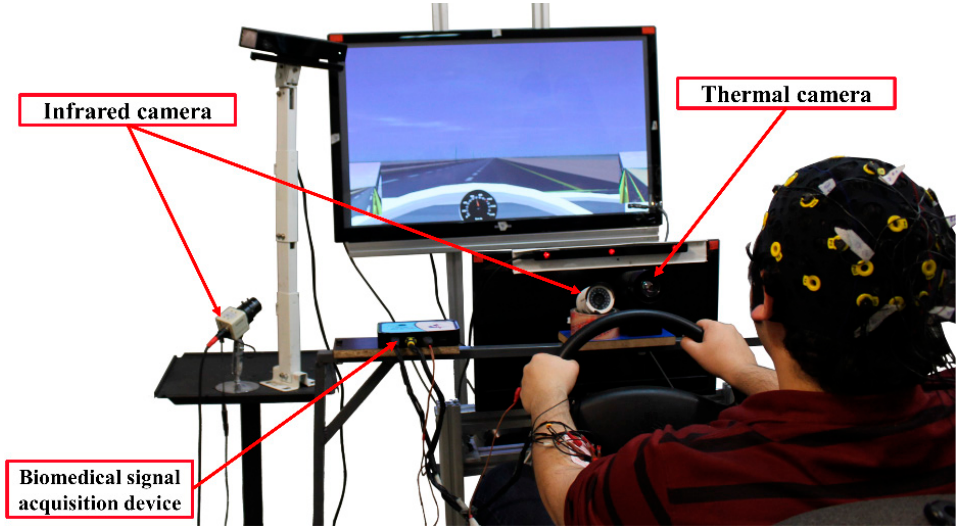
Figure 1. Nasir Semi 003TM driving simulator and placement of data acquisition devices. In this study, only data measured from thermal camera and ECG signals were used.